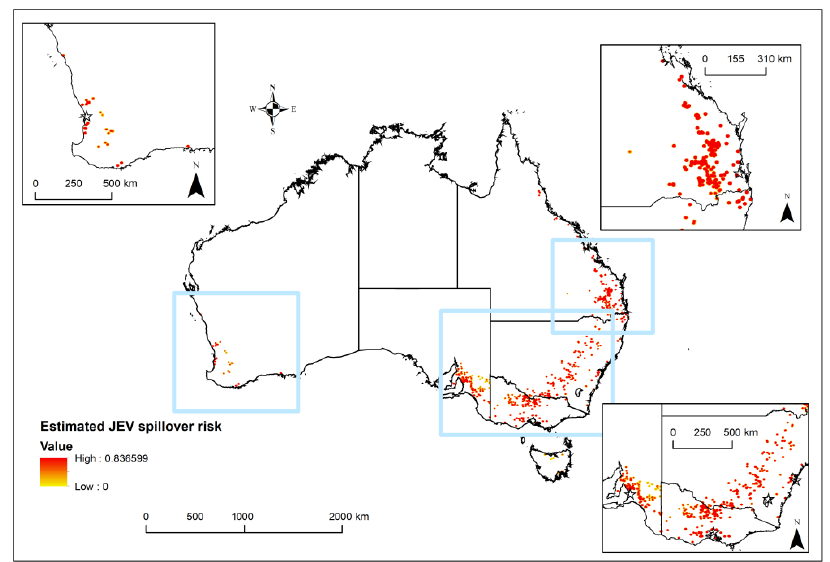
Figure 5. The estimated risk of epidemic JEV transmission in Australia, where the estimated risk ranges from zero (white) and low (yellow) to high (red). This shows a combination of free roaming wild species (water birds OR feral pigs) AND vectors AND domestic pigs. The squares identify the inset regions, expanded for ease of viewing.